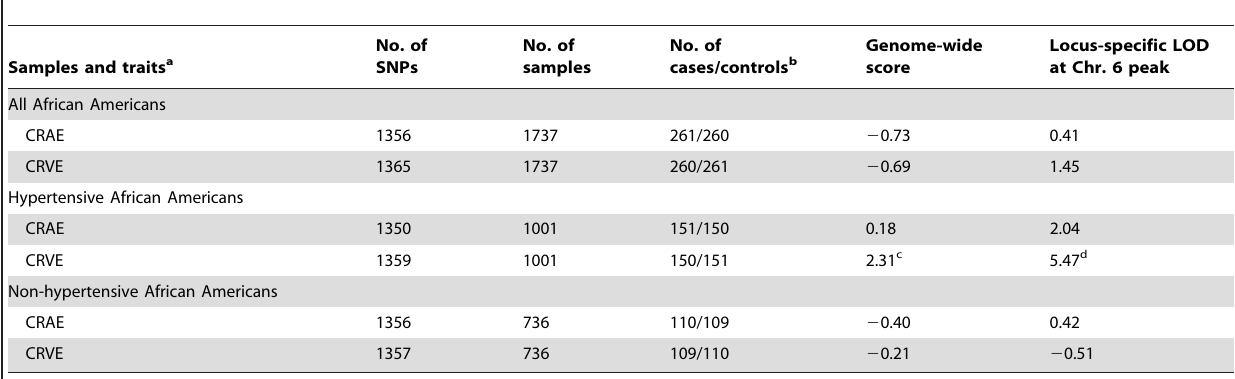
Table 2. Summary of locus-specific scores from the admixture scans of retinal vascular caliber.